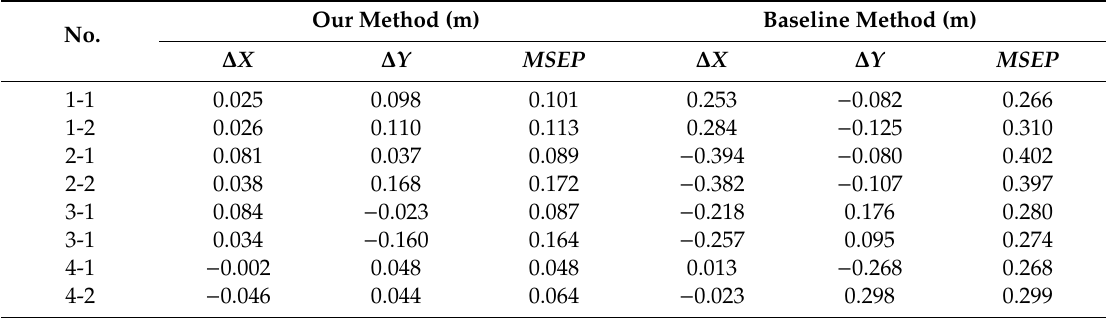
Table 8. Comparison of the positioning accuracy of different image content.